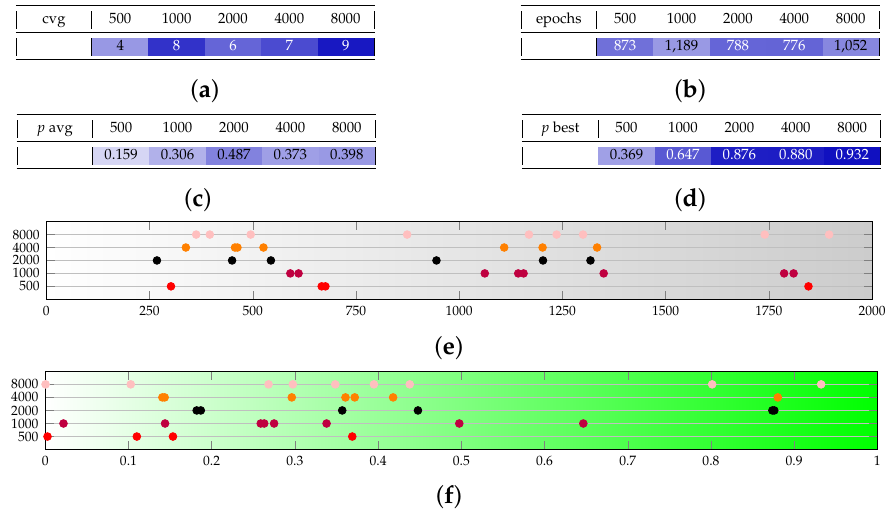
( f ) (f) Visual representation of the p -value. Figure A6. Test set E provides a sensitivity analysis on the number of shots s . ( a ) Converging runs, out of 10. ( b ) Number of epochs before convergence, on average. ( c ) p -value for the χ 2 test once convergence is reached (average over converging runs). ( d ) p -value for the χ 2 test once convergence is reached (best run). ( e ) Visual representation of the epochs before convergence. ( f ) Visual representation of the p